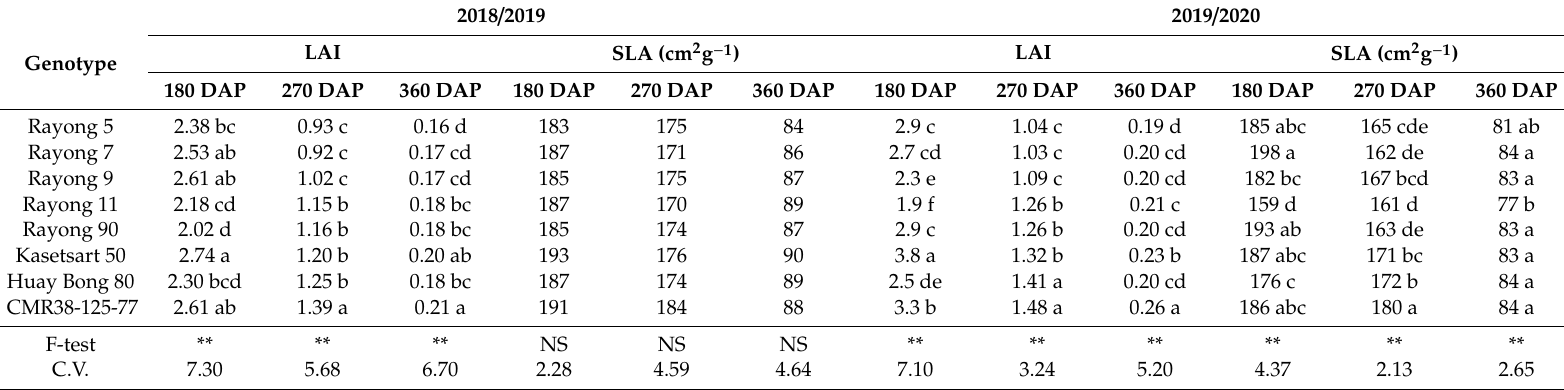
Table 3. Leaf area index (LAI) and specific leaf area (SLA) at di ff erent days after planting (DAP) for eight cassava genotypes grown in 2018 / 2019 and 2019 / 2020.